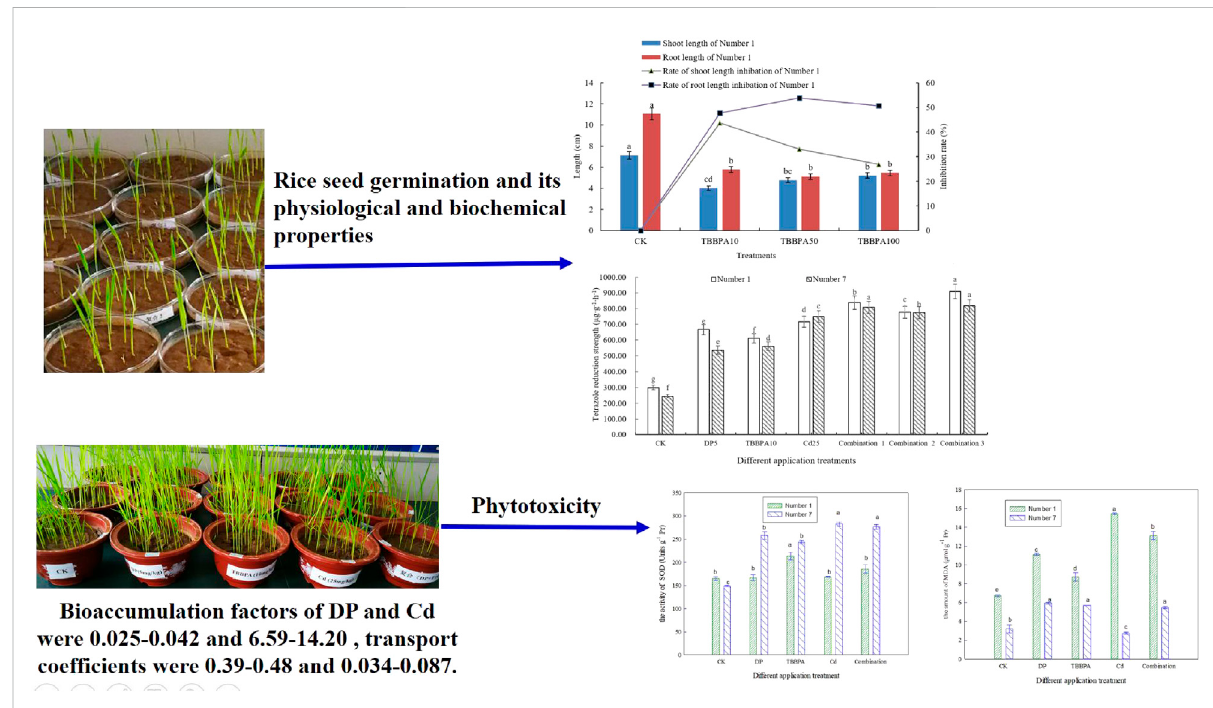
(cid:129) The activity of superoxide dismutase and catalase of two rice varieties was improved, and a large amount of malonyldialdehyde was induced. (cid:129) There was no signi fi cant difference in the bioaccumulation of DP in two rice varieties, but TBBPA and Cd were more easily bio accumulated in the Number 1